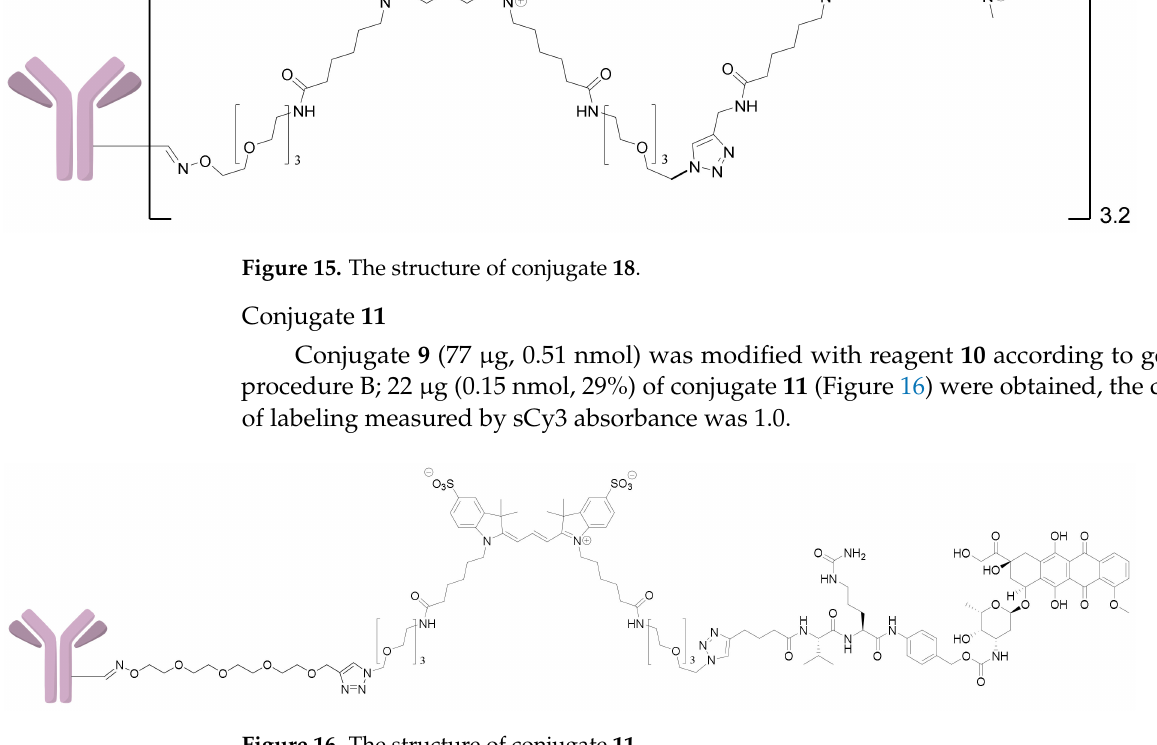
Figure 16. The structure of conjugate 11 . Conjugate 14 Conjugate 13 (20 µ g, 0.13 nmol) with an average degree of labeling of 2.5 was modified with reagent 10 according to general procedure B; 9.1 µ g (0.059 nmol, 46%) of conjugate 14 (Figure 17) were obtained, the degree of modification was 84%.